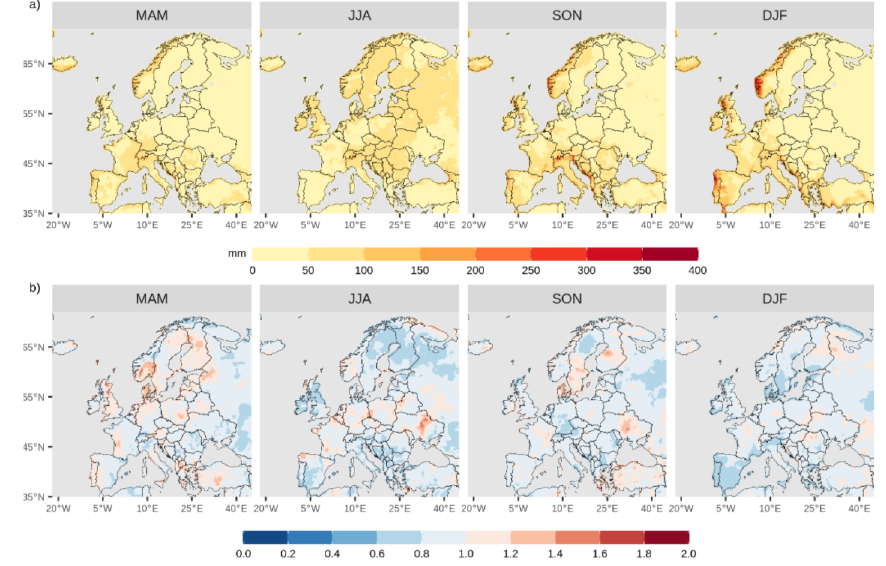
Figure 9. Spatial distribution of ( a ) MAE and ( b ) SPR for calibrated ECMWF SEAS5 ensemble seasonal forecasts of precipitation (one-month lead time) over Europe (land only) with respect to ERA5 reanalysis over